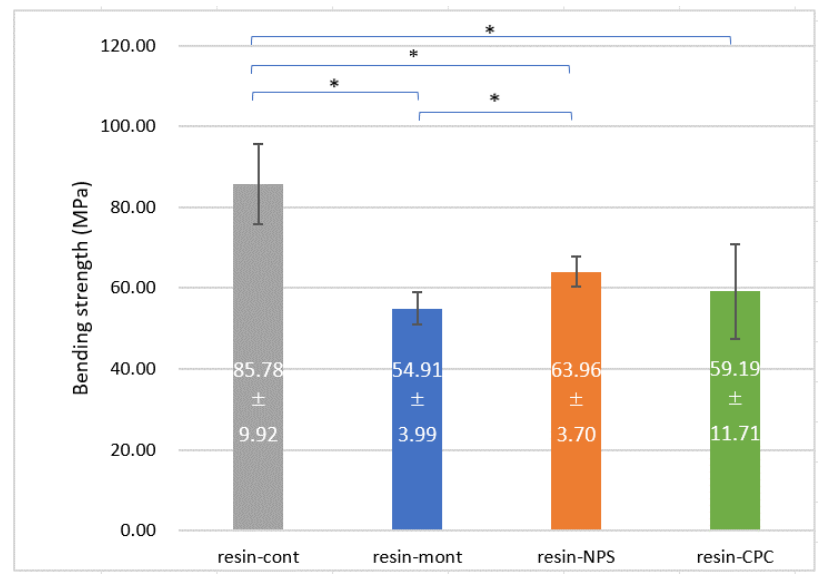
Figure 5. Results of 3-point bending test (*: p < 0.05).